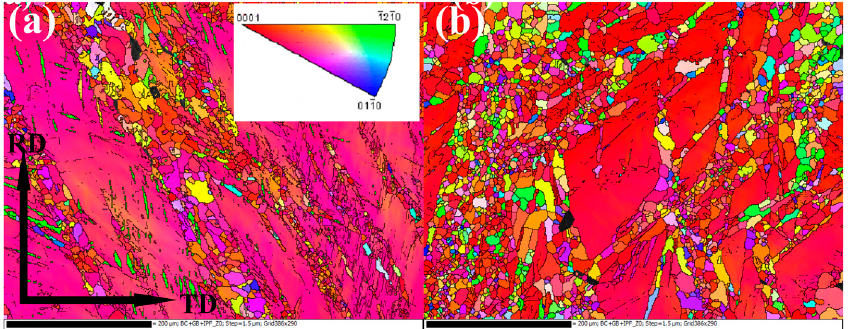
Figure 5. Inverse pole figures ofAZ31 alloys HSRMFed to different accumulated strain with a pass strain of ∆ ε = 0.1, ( a ) 0.2 and ( b ) 0.3.